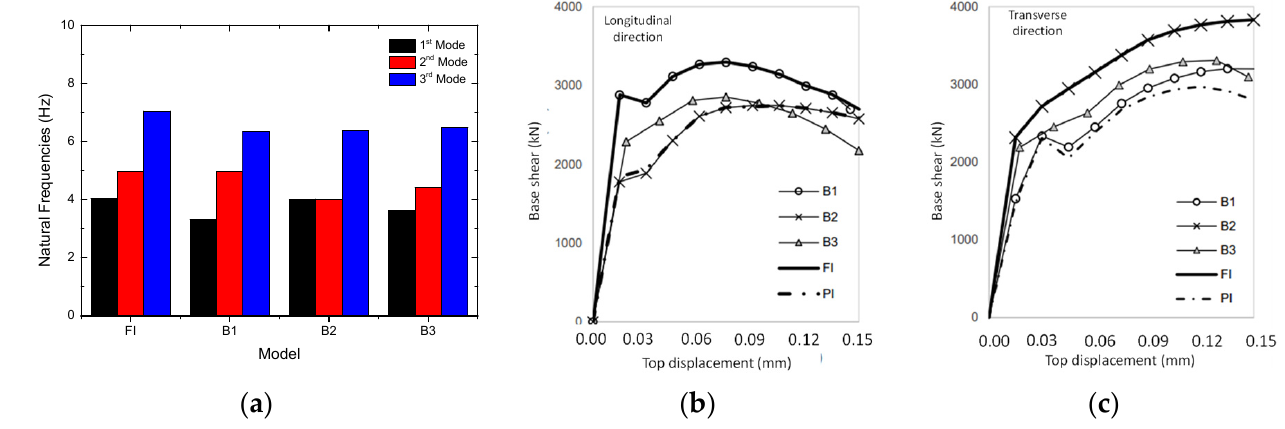
Figure 13. Parametric study B: ( a ) natural frequencies; ( b ) capacity curve (longitudinal direction); and ( c ) capacity curve (transverse direction).